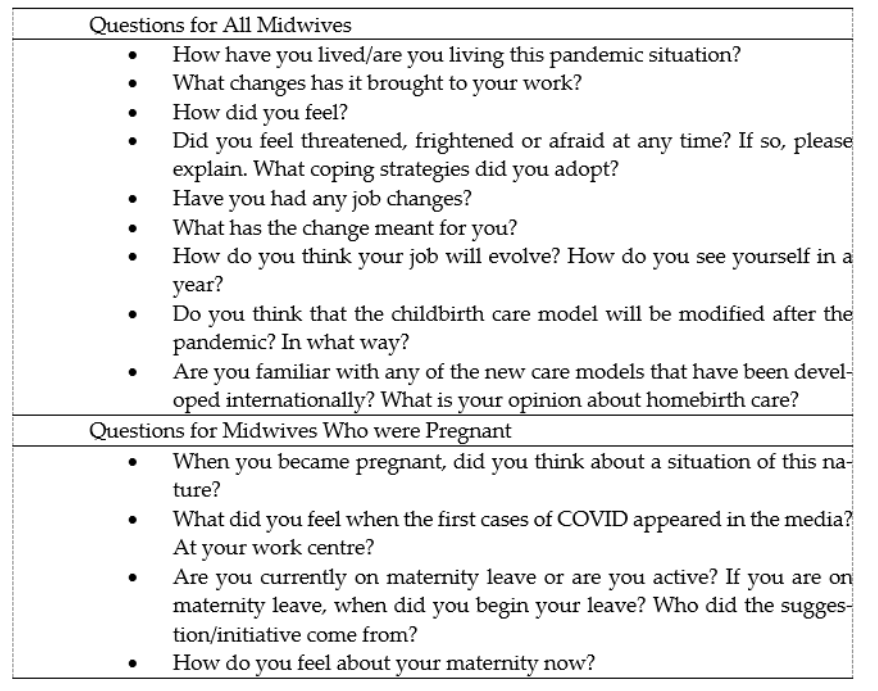
Figure 1. Interview outline.